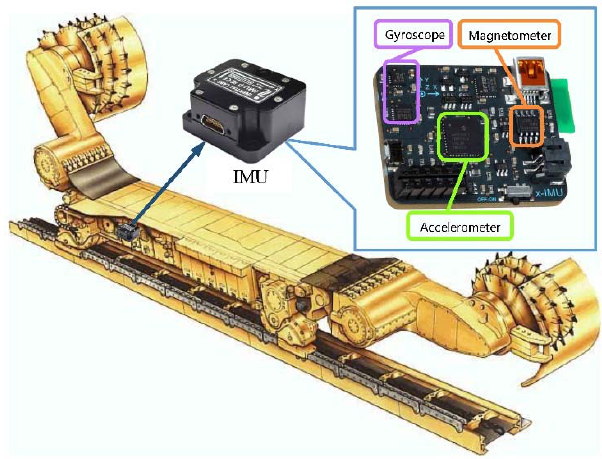
Figure 2. Shearer positioning system based on strapdown inertial navigation system (SINS).